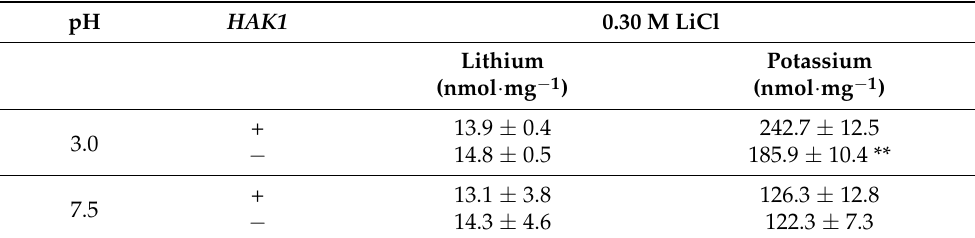
Table 2. Intracellular lithium and potassium in Candida albicans